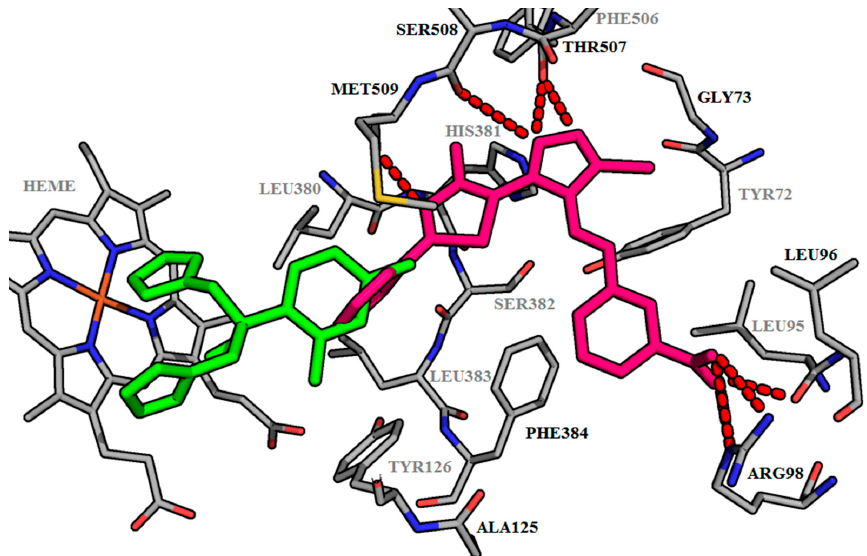
Figure 3. Binding mode of Fluconazole and B10 . The active site of lanosterol 14 α -demethylase is depicted as sticks. The Fluconazole is depicted in green; the Schiff base B10 in pink. The hydrogen bonds are depicted as dashed red lines. The foreground amino acids are in grey.